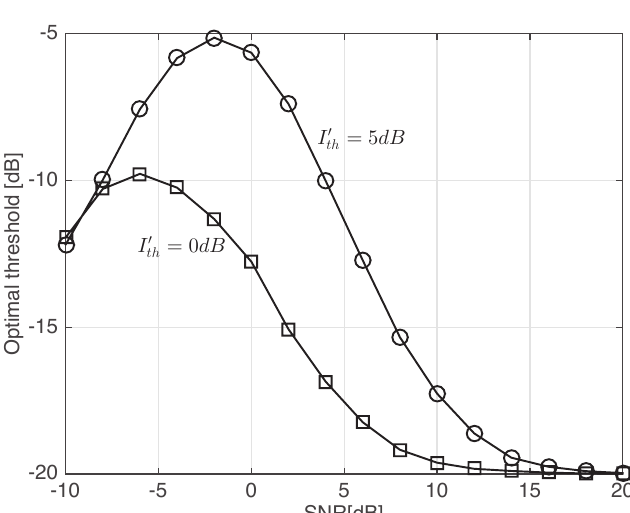
Figure 5. Optimal threshold in the proposed scheme when all channels are i.i.d. , N = 5, and I (cid:48) 5 dB.